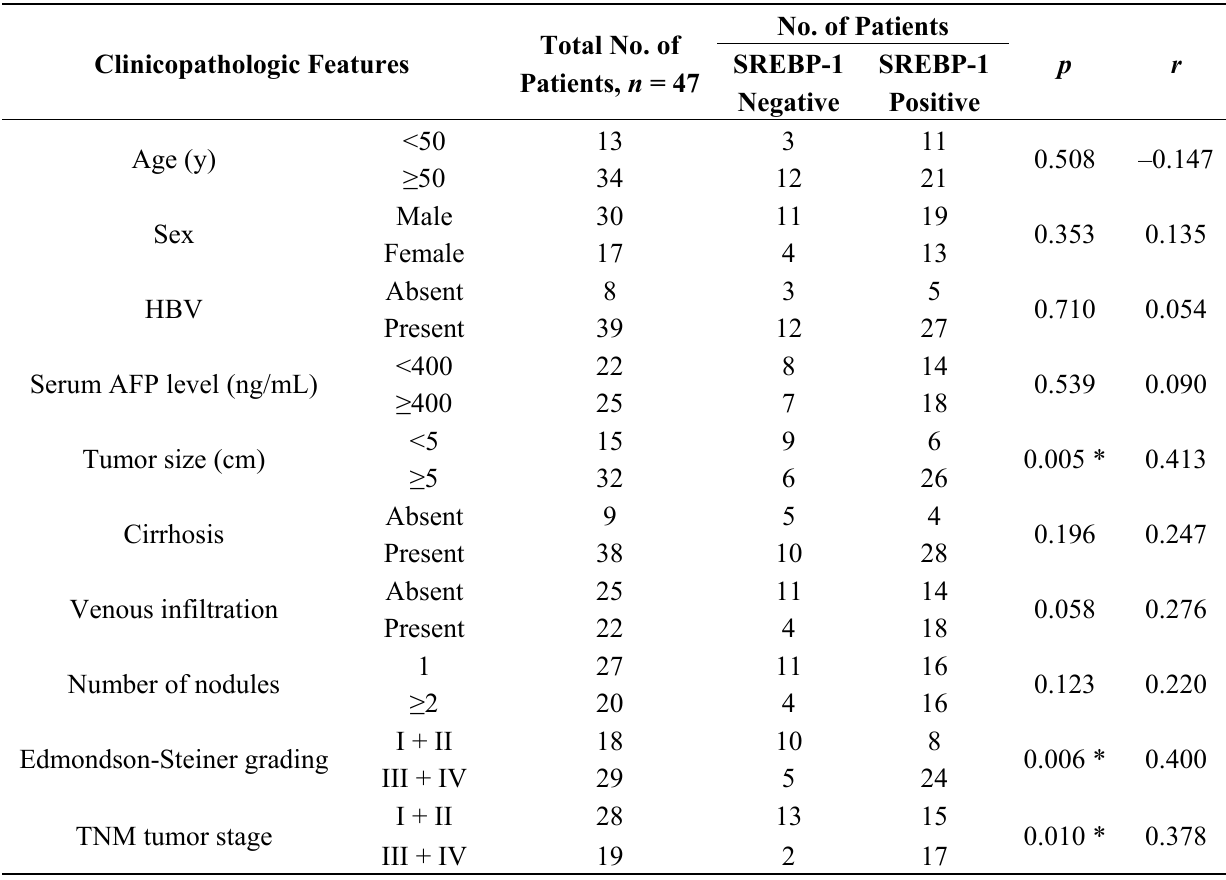
Table 1. Clinical correlation of SREBP-1 expression in HCC ( n =